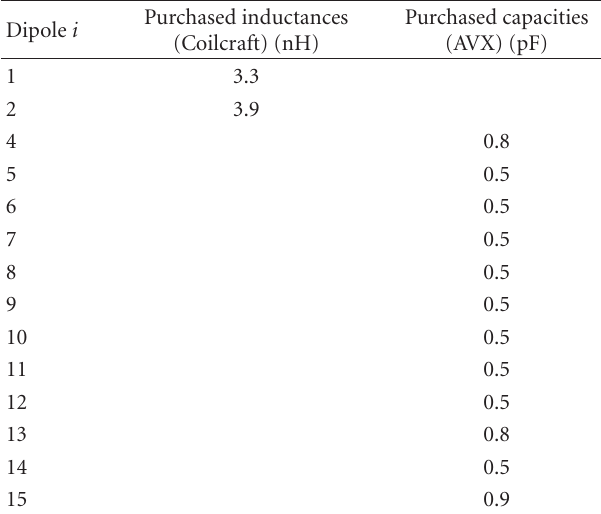
Figure 29: E - and H -plane cuts of the radiation pattern at 2.45GHz. Table 6: The objective lumped elements are replaced by in-stock values.